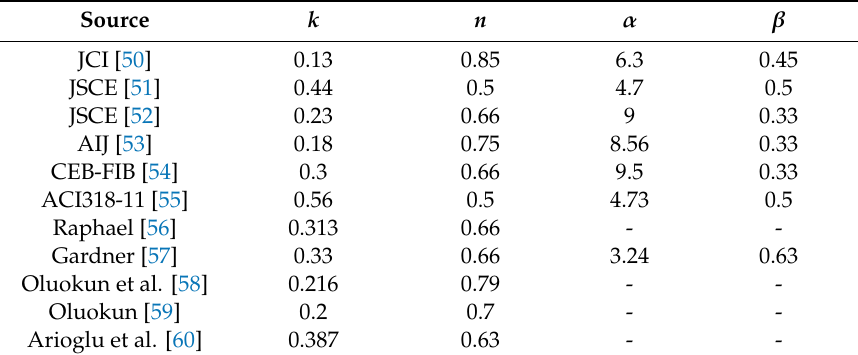
Table 2. Coe ffi cients k, n, α , β [49]. Table 2. Coefficients k, n, α , β [49].